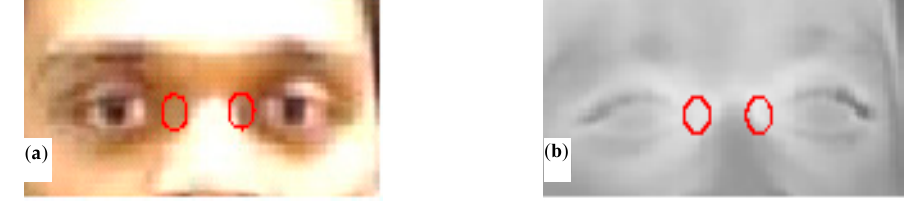
Figure 10. Canthi regions in ( a ) a visible and ( b ) an IR images [19].